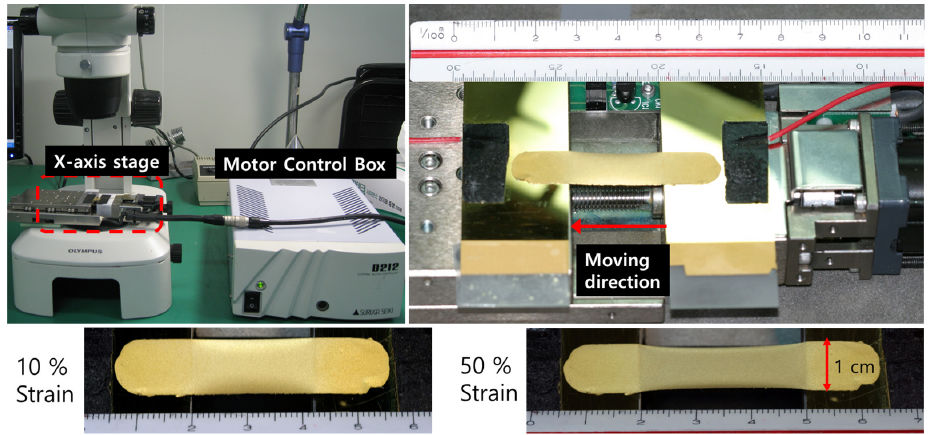
Figure 8. Uniaxial tensile strain and cycling strain test setup.